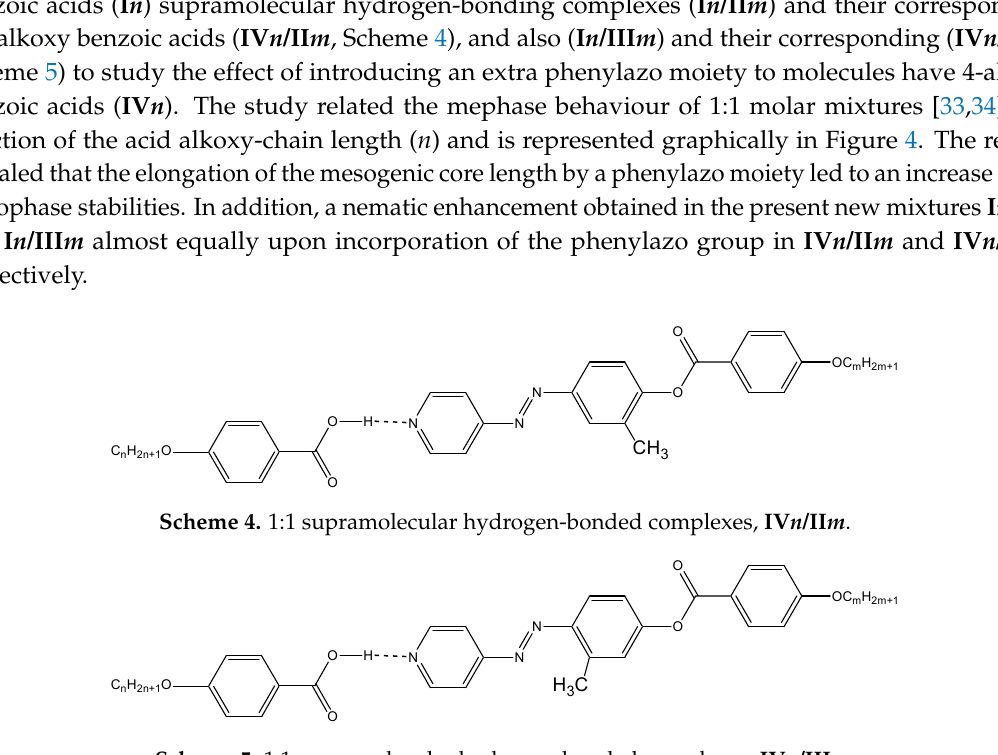
Figure 3. PLM textures of the supramolecular complex I 10/ II 8 ( a ) SmC phase at 120.0 o C; and ( b ) nematic phase at 181.0 o C.